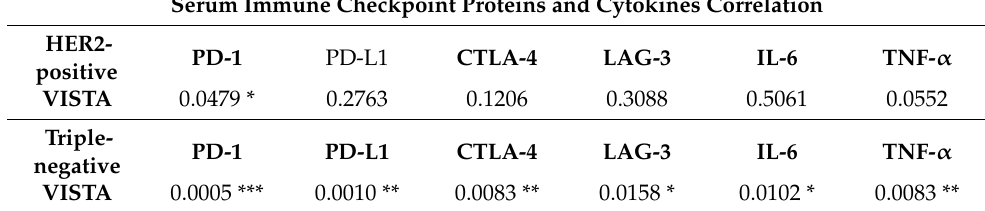
Table 3. Spearman’s correlation between serum VISTA levels and immune inflammation mediators, in cats with HER2-positive, or triple-negative mammary Figure 3. Serum VISTA levels in cats with mammary carcinoma were correlated with several immune checkpoint proteins, namely ( A ) PD ‐ 1 (*** p < 0.0001), ( B ) PD ‐ L1 (*** p < 0.0001), ( C ) CTLA ‐ 4 (*** p < 0.0001), ( D ) LAG ‐ 3 (*** p = 0.0002), ( E ) IL ‐ 6 (** p = 0.0016) and ( F ) TNF ‐α (*** p < 0.0001) serum levels.